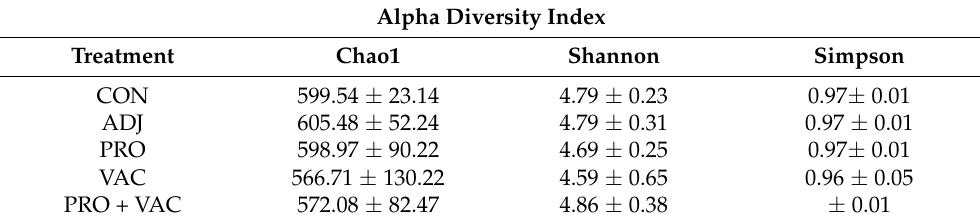
Table 3. Alpha diversity indices (Chao 1, Shannon, and Simpson) of gut bacterial communities of Nile tilapia from following groups: CON = control; ADJ = adjuvant; PRO = probiotics; VAC = vaccinated; PRO + VAC = probiotics + vaccine.